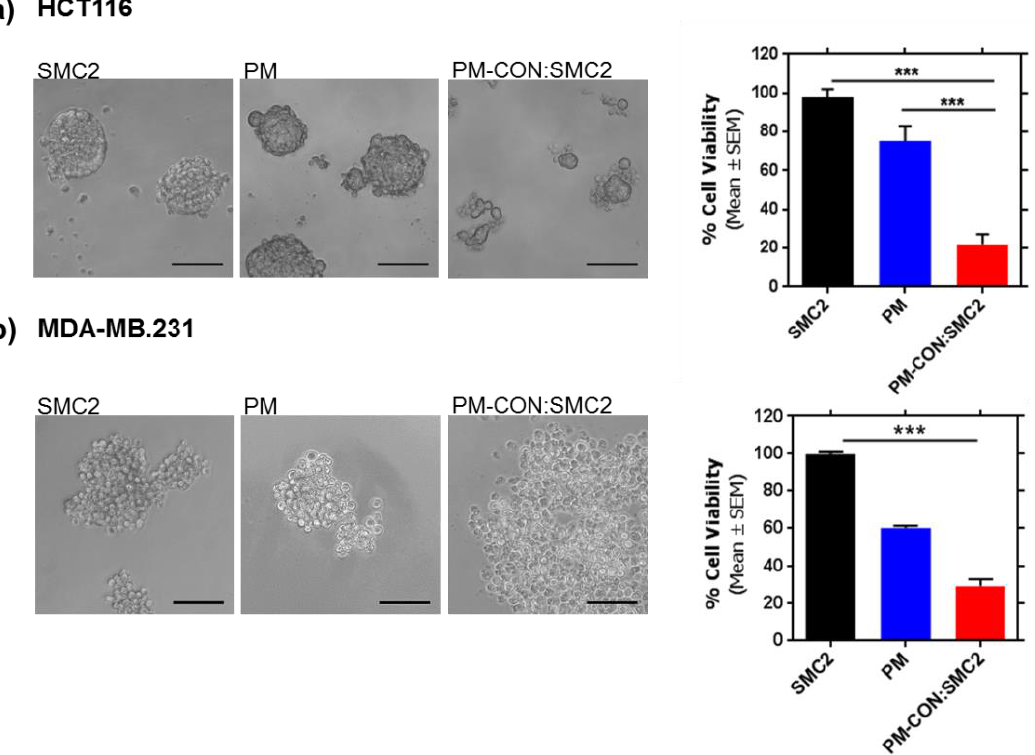
Figure 5. PM-CON:SMC2 in vitro e ffi cacy in CSC. Left panels, microscopy images of HCT116 ( a ) and MDA-MB-231 ( b ) tumorspheres after treatment with Ab-SMC2 (6.58 µ g / mL), control PM (1 mg / mL of Pluronic ® 127) and PM-CON:SMC2 (6.58 µ g / mL of antibody and 1 mg / mL of Pluronic ® 127). Scale bar correspond to 100 µ m. Right panels represent cell viability assays in HCT116 and MDA-MB-231 spheres growing for 7 days in non-adherent conditions. *** p < 0.001.